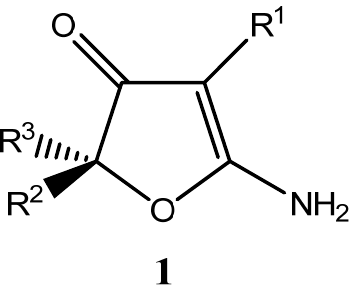
Figure 1. General structure of